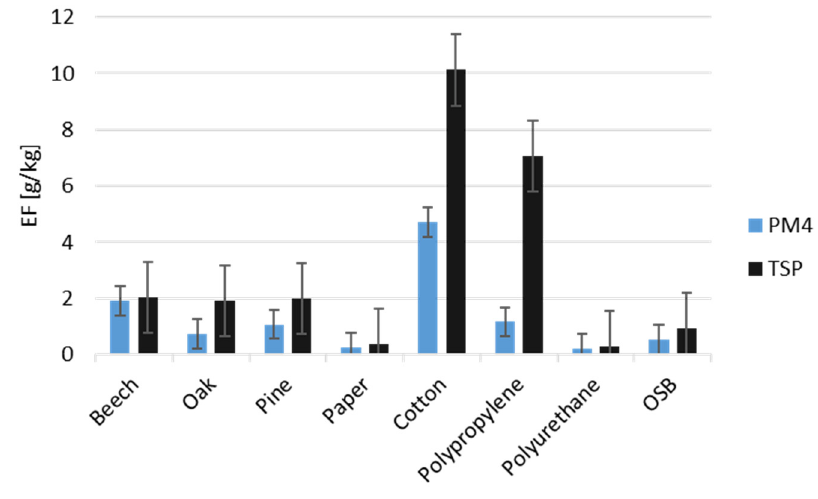
Figure 3. Emission factors during combustion of different types of materials ( r = 0.849, p = 0.008).